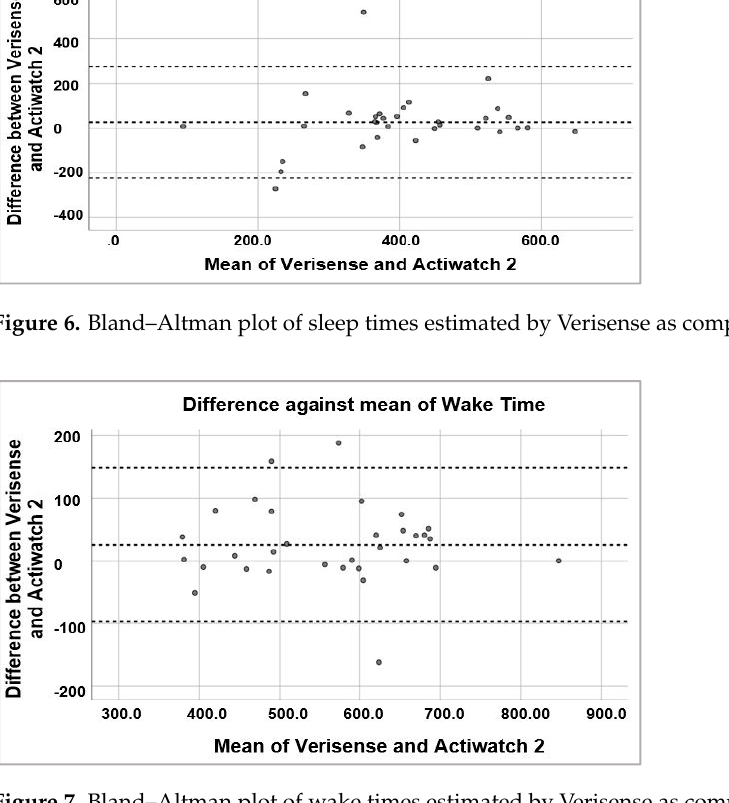
Figure 8. Bland–Altman plot of TST estimated by Verisense as compared to Actiwatch 2. 4. Discussion To our knowledge, this is the first validation study where the Verisense IMU was compared to an actigraph for activity and sleep monitoring. In comparing the accuracy of Verisense, a novel research-grade wearable sensor, against a clinical/research-grade actig- raphy device, Actiwatch 2, we find that the former device performs similarly in the esti- mation of epoch-by-epoch activity scoring and sleep parameters, although future studies on PA level classifications need further examination. There are notable differences between the Verisense and the Actiwatch 2. While pre- sent on the Actiwatch 2, the Verisense lacks a light sensor, a feature often useful in iden- tifying bed and wake times. The Actiwatch 2 stores data at a lower average resolution (e.g., 15 s and 30 s epochs at 32 Hz) in comparison to the Verisense which is capable of raw data monitoring and storage ranging up to 1600 Hz, facilitating higher resolution data with potential for greater accuracy. Verisense devices also remotely uploads all data to a secure cloud portal, eliminating the need for participants to attend a research facility to have data from the device downloaded, which is necessary with the Actiwatch 2. Signifi- cantly, Verisense provides access to raw accelerometer data which in place of a proprie- tary unit such as activity counts and filtered data which is now a desired part of research and increasing in adoption [45]. Verisense also has a long-lasting battery life of up to 6 months with no need for recharging, while most devices designed for clinical trials require frequent recharging and manual data upload. For longer duration longitudinal studies, these attributes of Verisense could be of significant benefit. The adoption of wearable technology in healthcare and clinical trials continues to increase, however the paucity of standards for sensor algorithms can hamper their utili- sation in research [79]. To address this, a healthcare industry open-wearables initiative